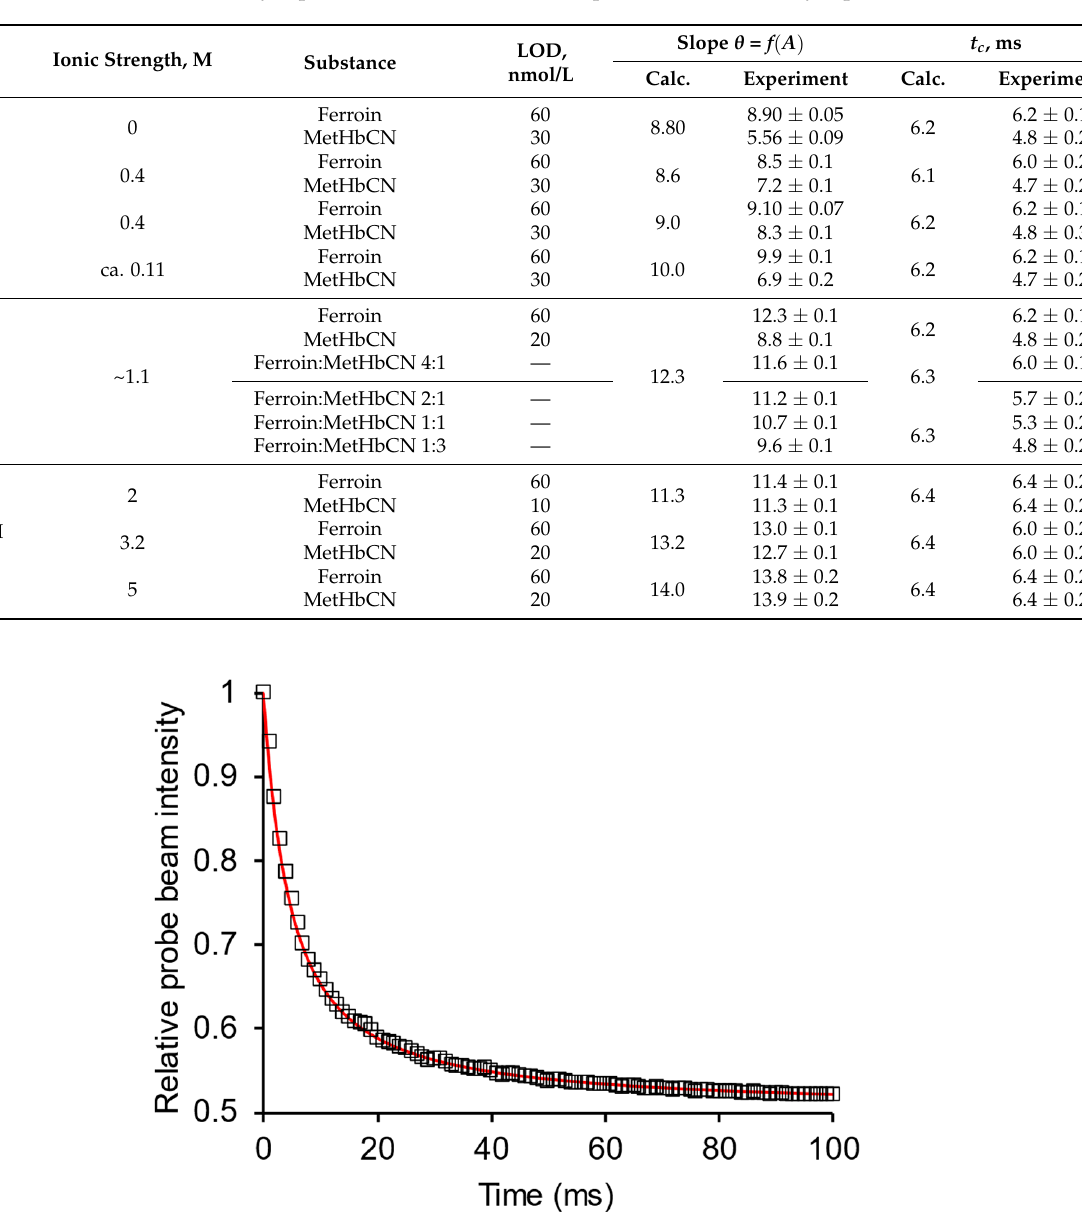
excitation power, 40.0 mW ( p = 0.95, n = 8). Theoretical characteristic times of the thermal lens were